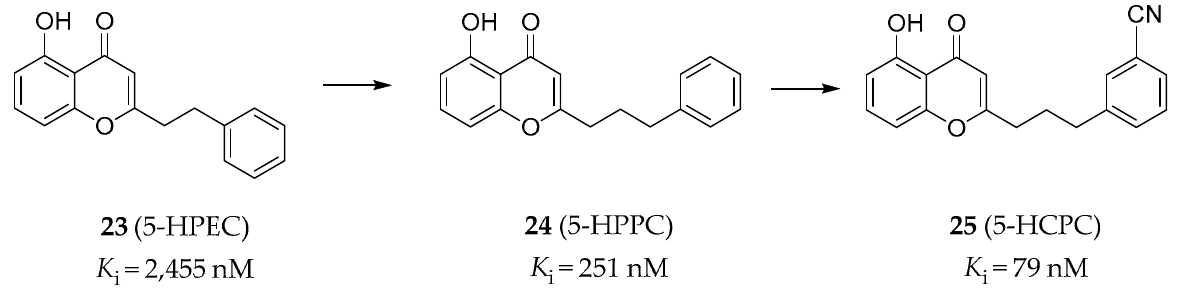
Figure 7. Representative chromone derivatives as non-nitrogenous 5-HT 2B R antagonists [138–140].